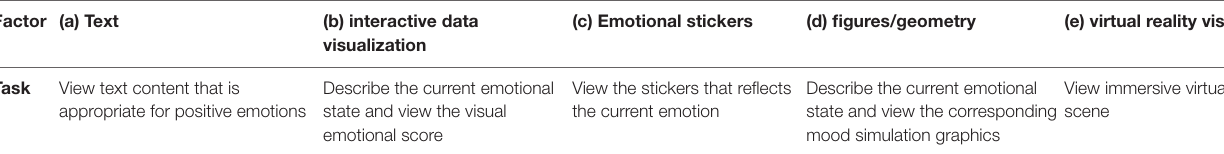
TABLE 2 | Multi-factor experimental scene.